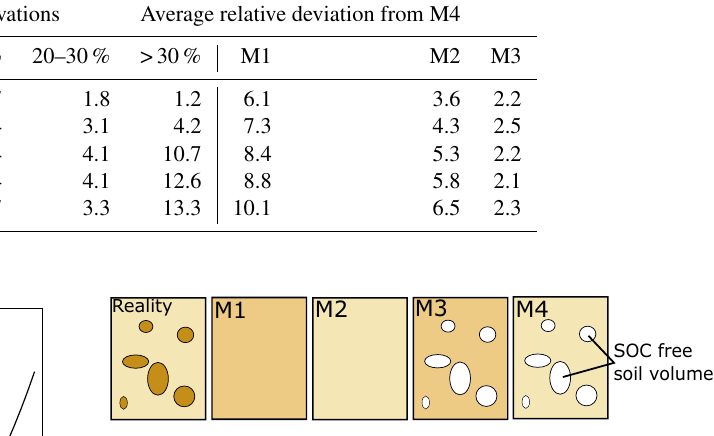
Figure 3. Schematic overview on the four methods applied to esti- mate the mass of soil needed to calculate soil organic carbon stocks. Different shades of brown are used to indicate different densities: the rock fragment fraction (ellipsoids) has the darkest brown and the fine soil fraction the lightest